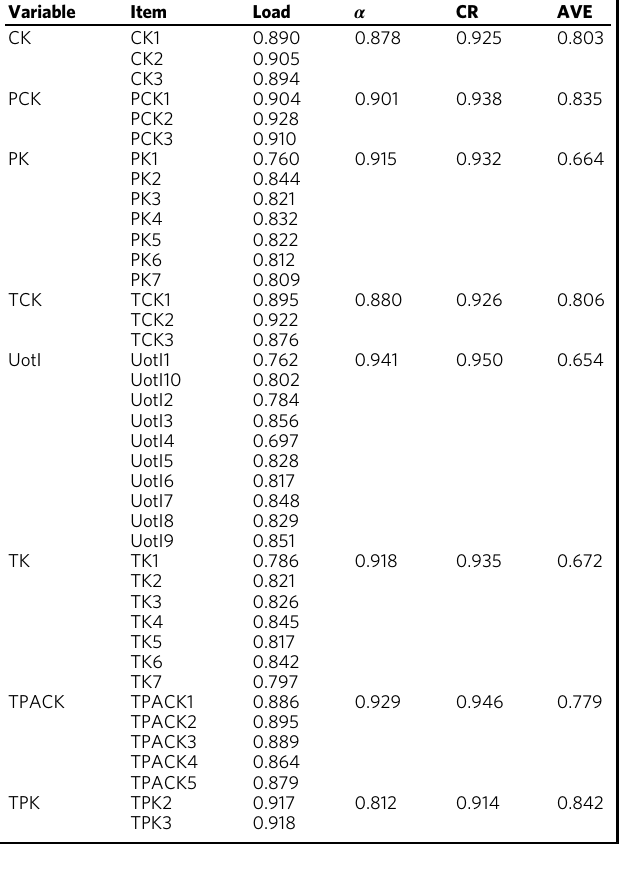
Table 3 Construct reliability and convergent